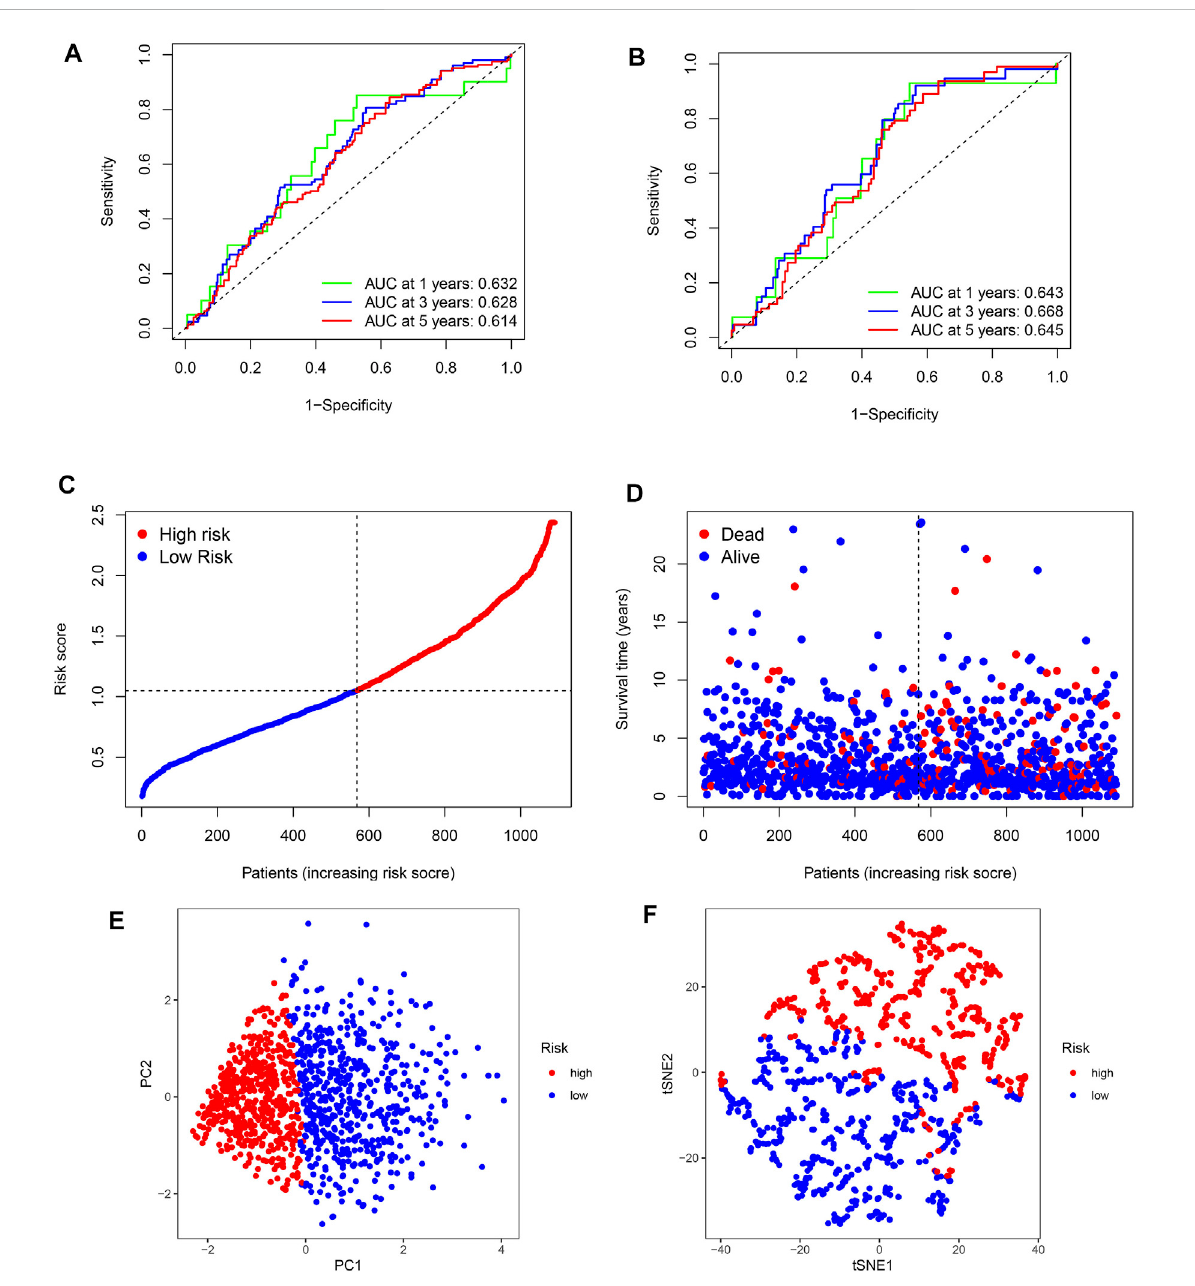
FIGURE 4 ROCcurvesandriskscoresofthesignatureinpredictingOSofpatientswithBC. (A,B)